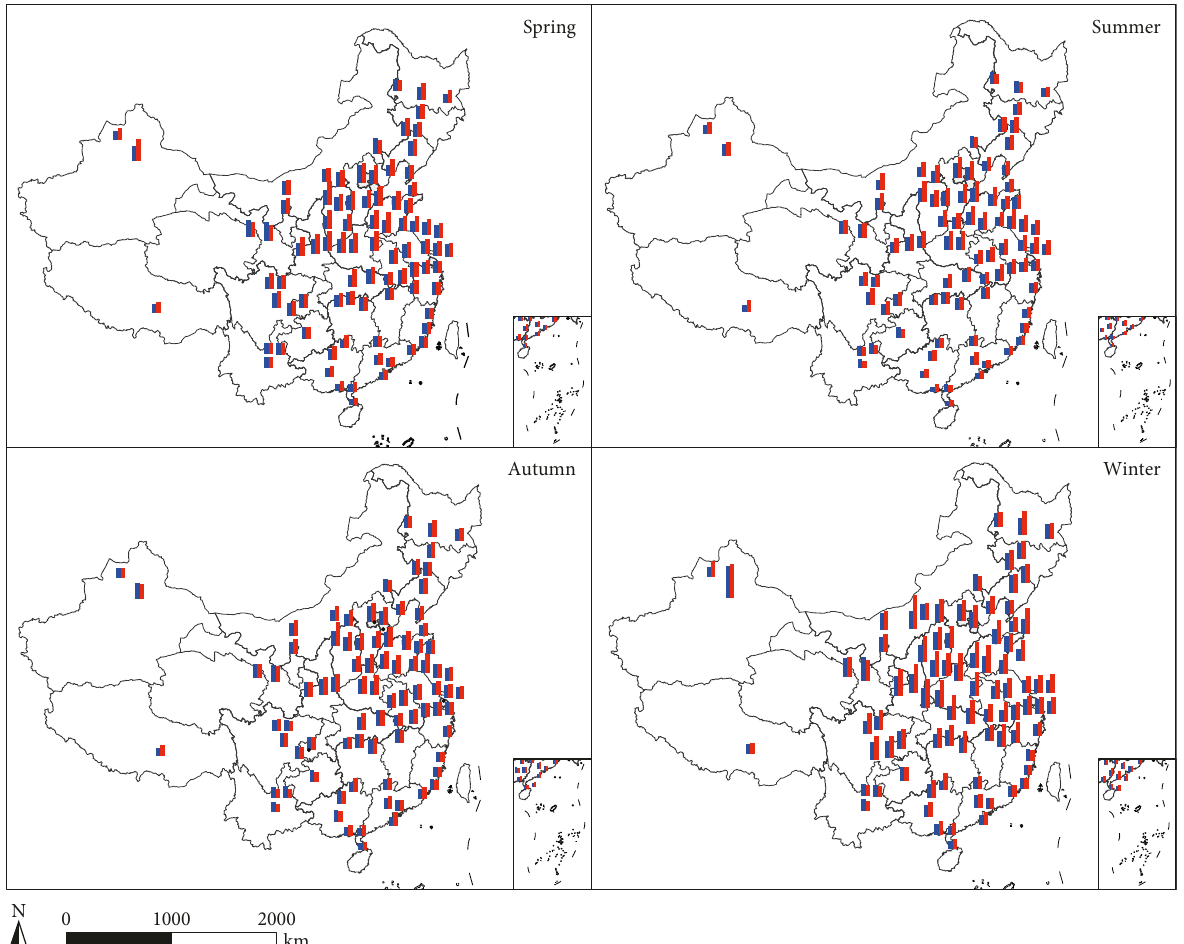
Figure 6: Seasonal changes of the API and